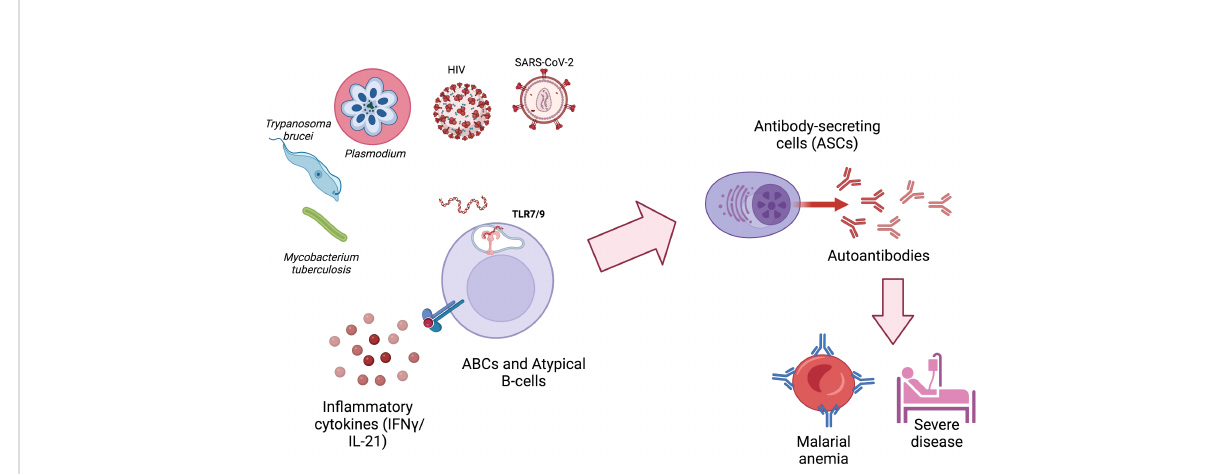
FIGURE 1 ABCs and atypical B cells are generated during different infections and secrete autoimmune antibodies that can contribute to pathology. ABCs and atypical B cells generation during infections requires at least two signals: 1) the activation of TLR9 or TLR7, typically by nucleic acids derived from the infectious agent or by host mitochondrial DNA released by neutrophil extracellular traps (NETs); 2) exposure to IFN- g and/or IL-21. Autoimmune antibodies generated by autoimmune antibody-secreting cells (ASCs) can contribute to pathology and severe disease. Created with